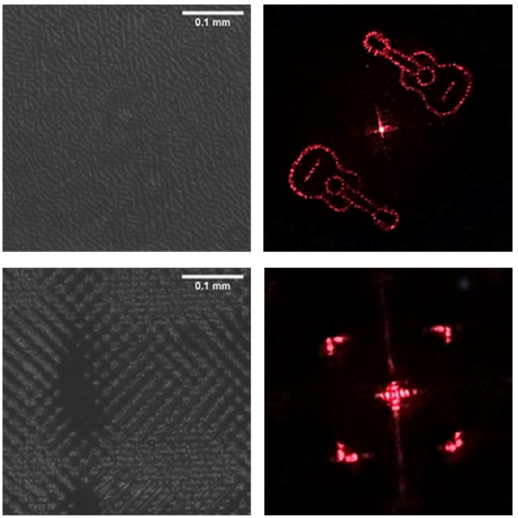
Figure 7. Recorded amplitude profiles ( left ) using the femtosecond laser and corresponding diffracted far field image ( right ).